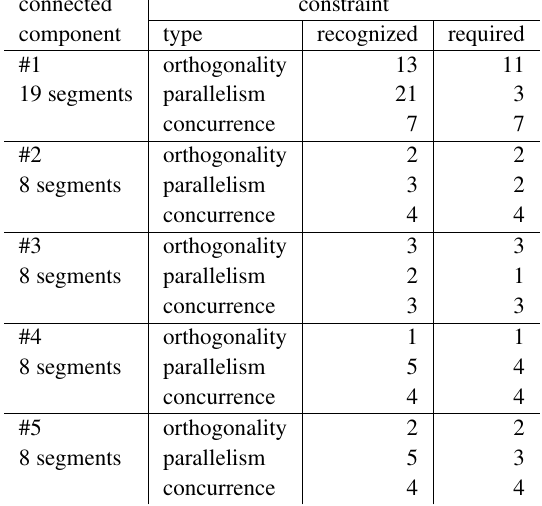
Table 3. Recognized and required constraints for the scene shown in Figures 6 and 7.